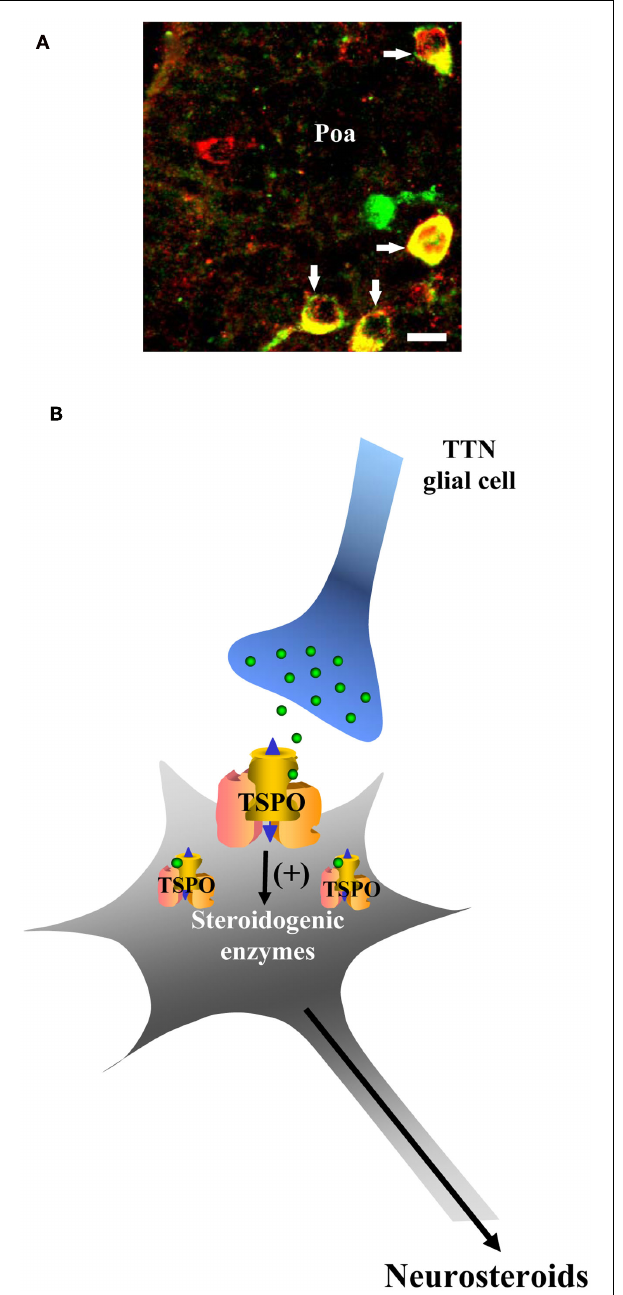
FIGURE 2 | Effect of the triakontatetraneuropeptide (TTN) on neurosteroid biosynthesis. (A) Immunohistochemical localization of 3 β -HSD-like immunoreactivity (red) and translocator protein (TSPO)-like immunoreactivity (green) in the anterior preoptic area (Poa) of the frog brain. 3 β -HSD-positive neurons that possessTSPO appear in yellow. For details regarding antibodies and immunohistochemical procedures, see reference by Do Rego et al. (1998). In brief, polyclonal antibodies raised in rabbit were used to label 3 β -HSD-containing neurons, and polyclonal antibodies raised in chicken were used to label theTSPO-expressing cells. Scale bars: 10 μ m. (B) Schematic drawing depicting the effect ofTTN on steroidogenic neurons.TTN, acting throughTSPO, stimulates the biosynthesis of 17OH- Δ 5 P, DHEA, and 17OH-P.